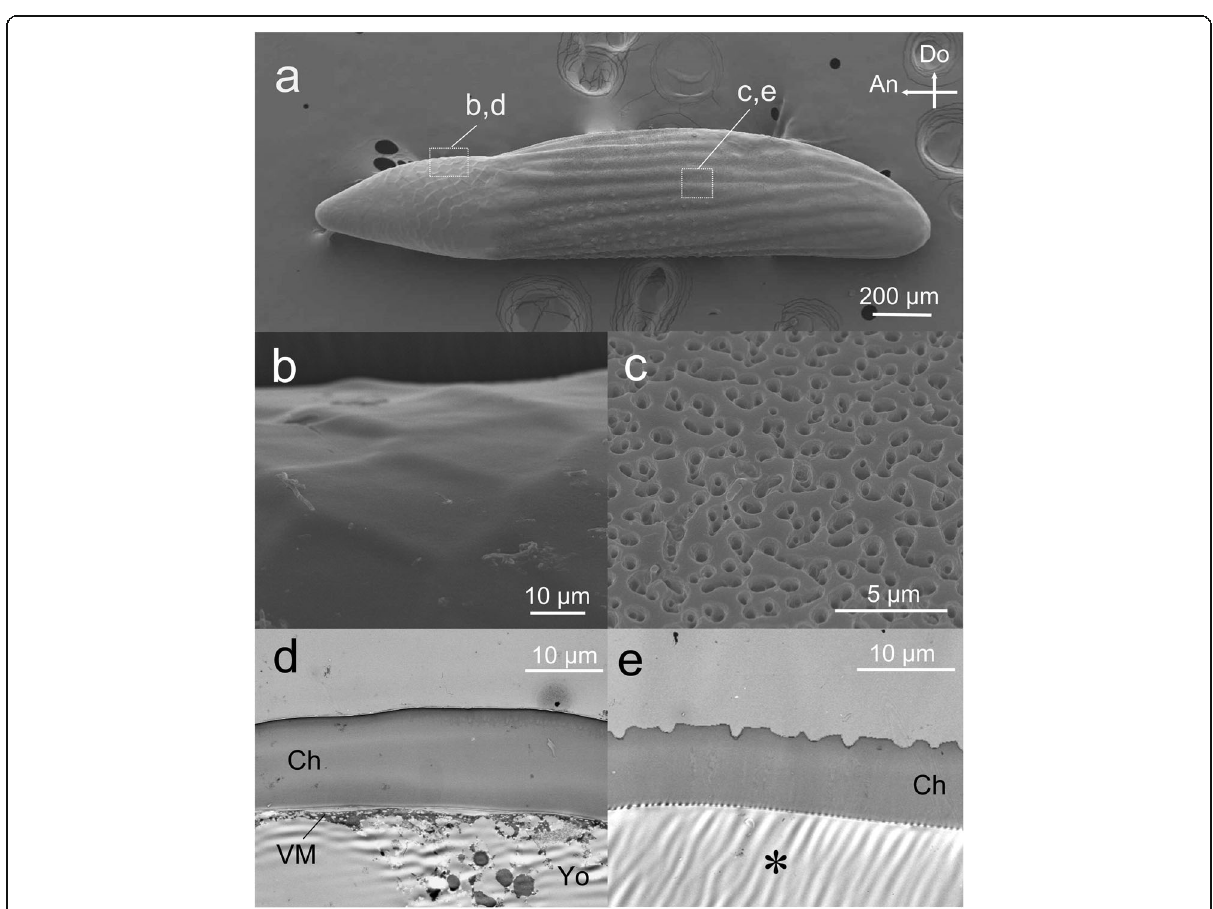
Fig. 2 Fine structure of the eggshell on the oviposition date. a A whole SEM image of an eggshell. Arrows indicate the anterior (An) and dorsal (Do) directions. b A magnified SEM image of the dorsal middle region of the anterior part, which contains the future cleavage site. c An SEM image of the lateral region in the posterior part. d A TEM image of ( b ). e A TEM image of ( c ). In this sample, the egg contents have been removed (*). Abbreviations: Ch, chorion; VM, vitellin membrane: Yo,